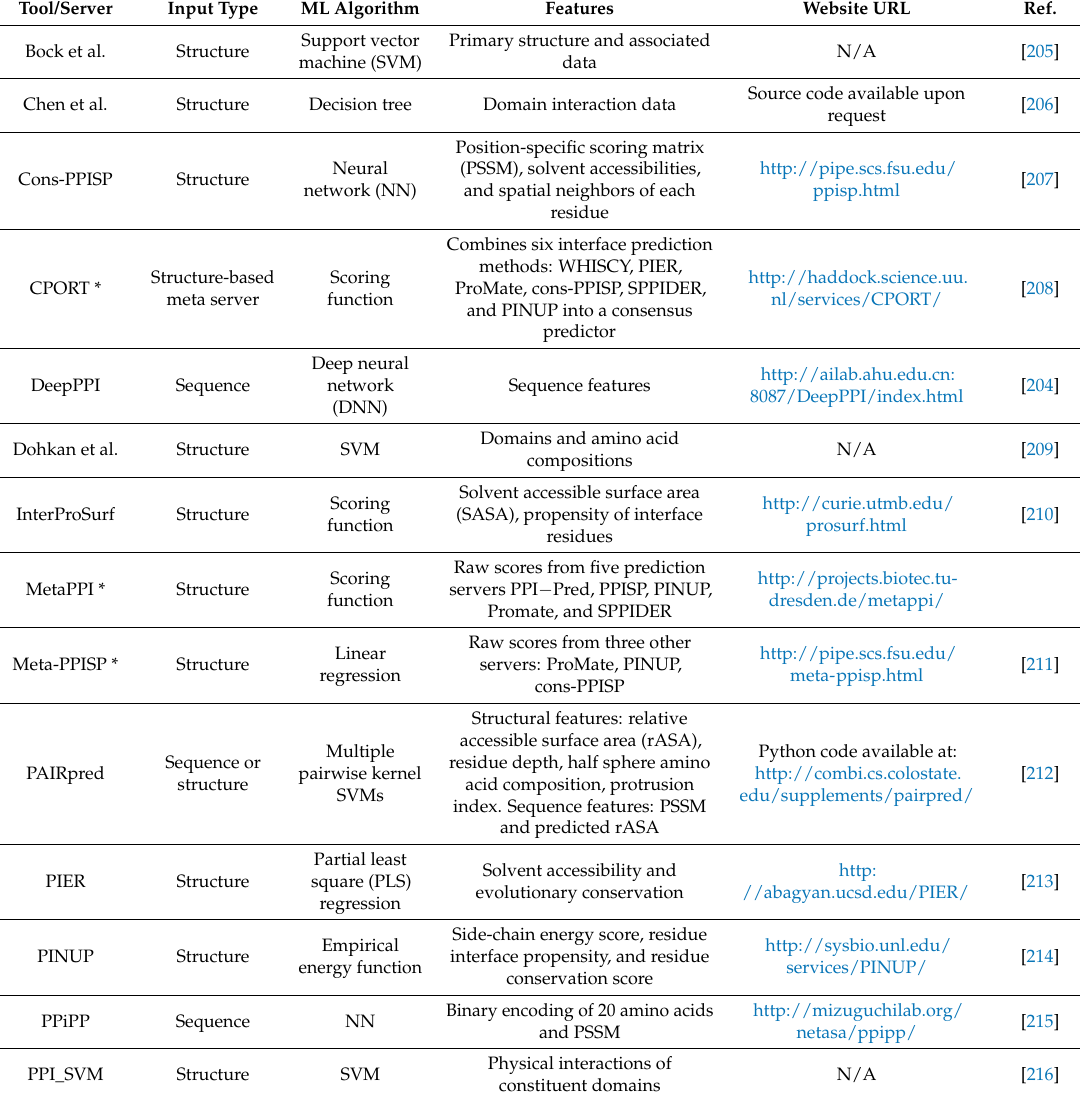
Table 3. Alphabetical listing of machine learning predictors for the identification of